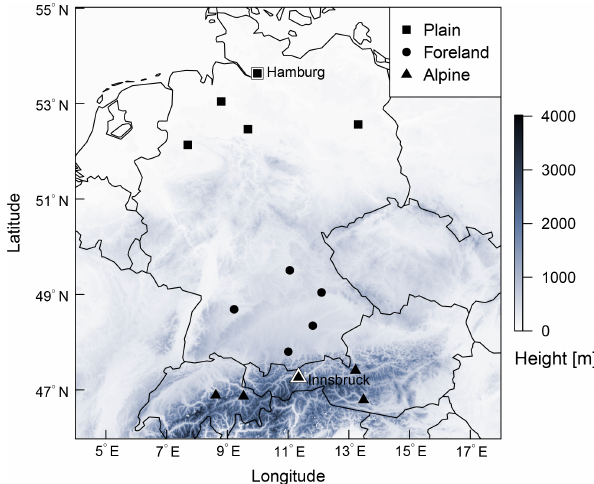
Figure 1. Overview of the study area with selected stations classi- fied as plain, foreland, and alpine station sites. The two highlighted and labeled stations, Hamburg and Innsbruck, are discussed in de- tail in Sect. 3.1. Elevation data are obtained from the SRTM-30m digital elevation model (NASA JPL,